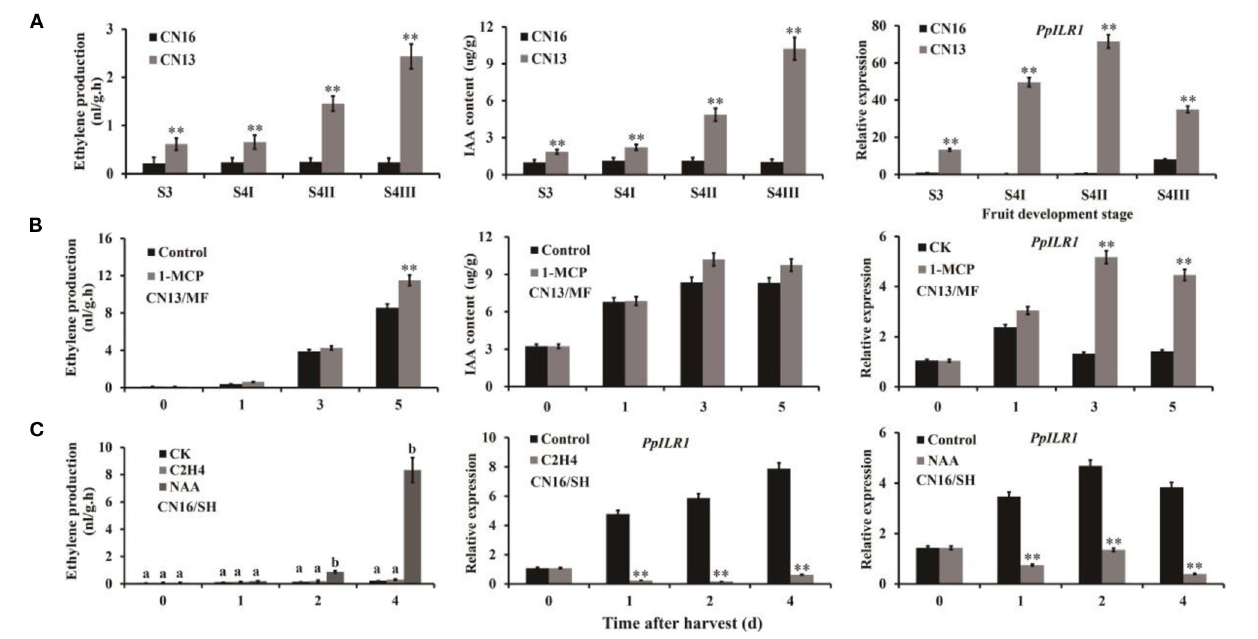
FIGURE 2 | Expression pattern of PpILR1 . (A) Ethylene and IAA content of “CN13” and “CN16” fruits during ripening, and the expression profile of PpILR1 in “CN13” and “CN16” fruits. (B) Ethylene and IAA content of “CN13” fruits harvested at the S4 II stage after treatment with 1-MCP, and the expression level of PpILR1 . (C) Endogenous ethylene production in “CN16” fruits harvested at the S4 III stage after treatment with NAA and ethylene, and the expression pattern of PpILR1 . Values represent the mean of three biological replicates. Asterisks (*) indicate significant differences. Different letters indicate significant differences at P < 0.05.